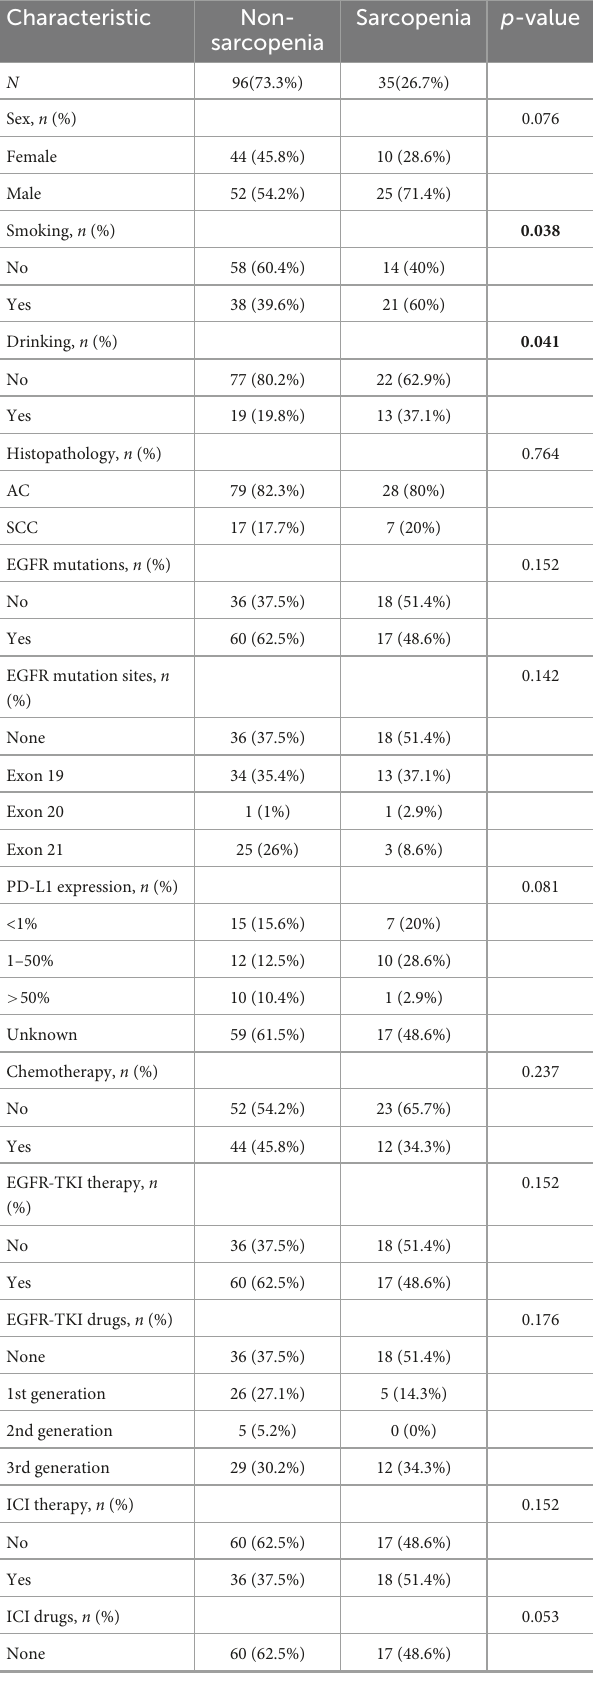
TABLE 1 Baseline characteristics of all